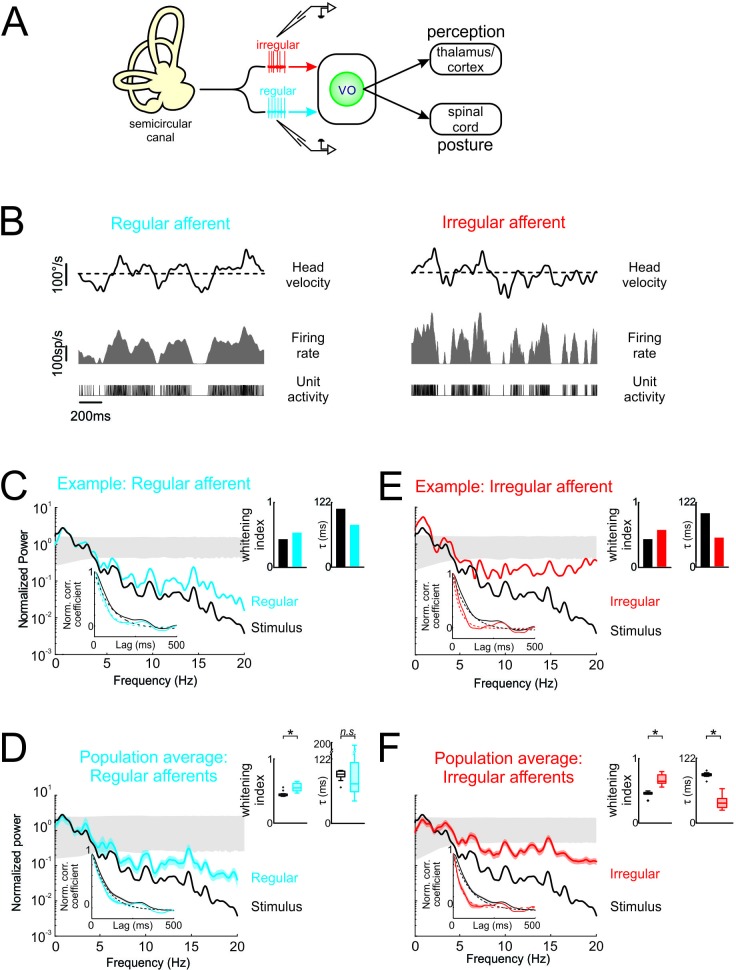
Vestibular afferents do not perform whitening of natural self-motion.(A) Same diagram as in Figure 1A, except that recordings were made from afferents. (B) Response of example regular (left) and irregular (right) afferents during natural stimulation. (C) Normalized power spectra of natural stimuli (black) and neural response (blue) for the example regular afferent. The lower left inset shows the autocorrelation function of the response (blue) and of the stimulus (black). Solid lines represent autocorrelation functions, while the dashed lines are exponentials fits. The upper right inset shows the whitening index (left) and correlation time (right). (D) Normalized population-averaged power spectrum for regular afferents (blue) with that of the stimulus (black). The lower left inset shows the population-averaged response autocorrelation function (blue). The upper right inset shows the population-averaged whitening index (left) and correlation time (right) values. The whitening index was not significantly different than that of the stimulus (Student’s t-test, p = 0.79, t(13)=0.27). The correlation time was significantly lower than that of the stimulus (Student’s t-test, p < 0.001, t(13)=2.9). (E) Normalized power spectra of natural stimuli (black) and neural response (red) for the example irregular afferent. The lower left inset shows the autocorrelation function of the response (red) and of the stimulus (black). Solid lines represent autocorrelation functions, while the dashed lines are exponentials fits. The upper right inset shows the whitening index (left) and correlations time (right). (F) Normalized population-averaged power spectrum for irregular afferents (red) with that of the stimulus (black). The lower left inset shows the population-averaged response autocorrelation function (red). The upper right inset shows the population-averaged whitening index (left) and correlation time (right) values. The whitening index was significantly higher than that of the stimulus (Student’s t-test, p < 0.001, t(11)=2.25). The correlation time was significantly lower than that of the stimulus (Student’s t-test, p < 0.001, t(11)=9.64). Gray bands show 95% confidence interval obtained using Poisson processes with the same firing rate as the experimental data for which the power spectrum is independent of frequency by definition (see Materials and methods). Error bars show ±1 SEM.